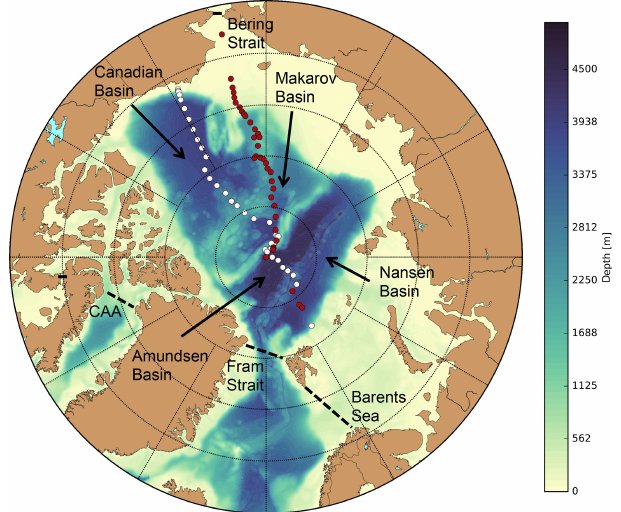
Figure 1. CFC-12 stations along the AOS94 (red) and Beringia 2005 expeditions (white). Other colors indicate the bathymetry of the Arctic Ocean, while the four dashed black lines show the bound- aries of the Arctic Ocean domain used in this